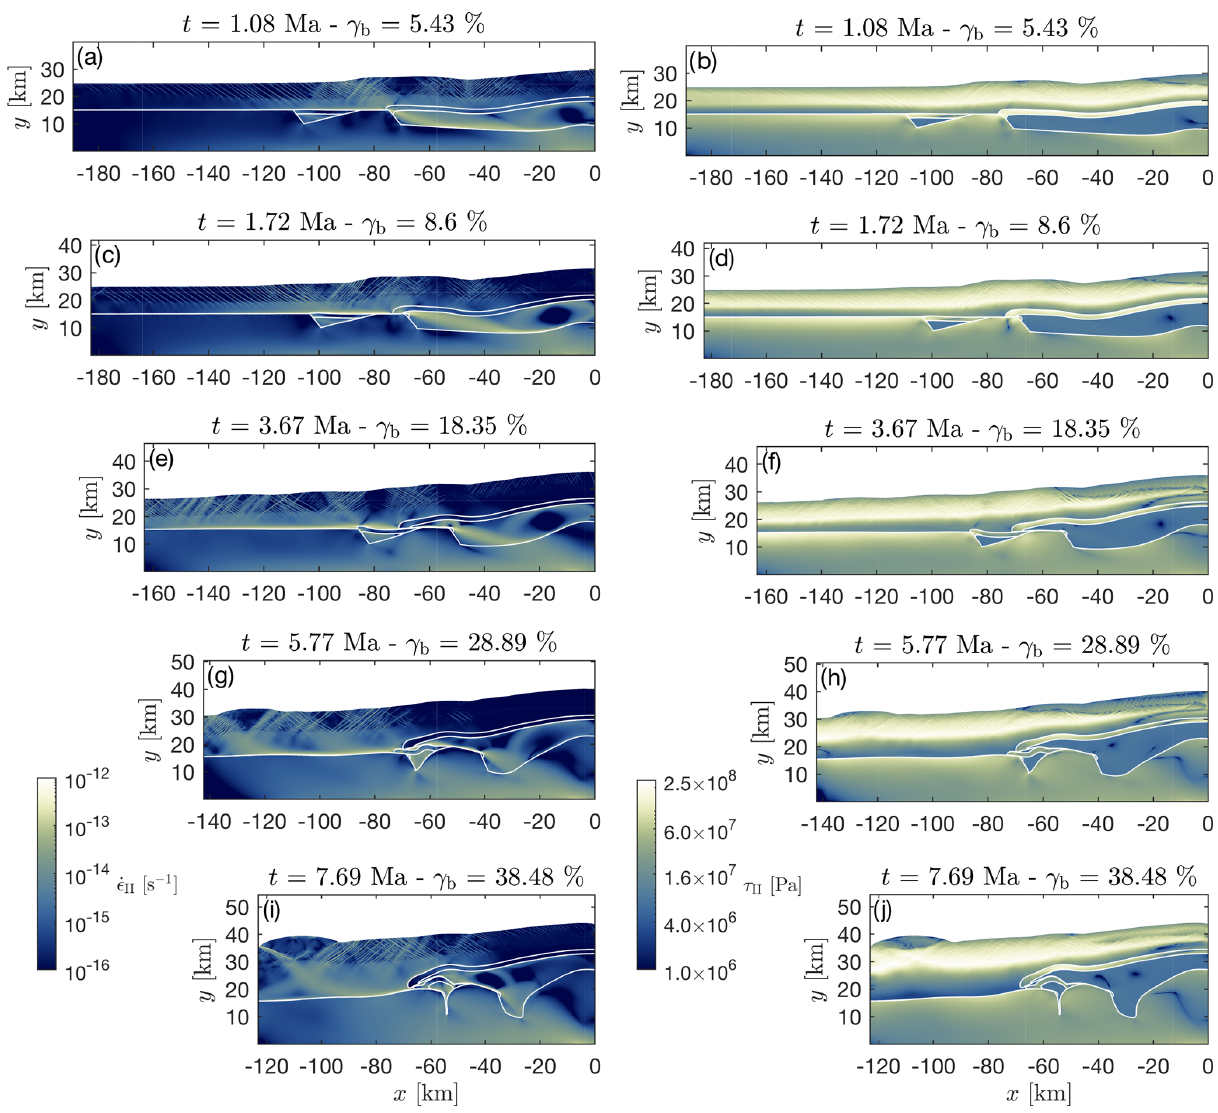
Figure 4. Evolution of the strain rate (left column) and deviatoric stress (right column) fields of the reference model for different times, t , and bulk shortening, γ b . Strain rate and deviatoric stress are quantified with the square root of the second invariant of the strain rate, ˙ (cid:15) II , and deviatoric stress, τ II , tensor, respectively. Magnitudes of ˙ (cid:15) II and τ II are displayed with logarithmic color scale. Color maps are from Crameri